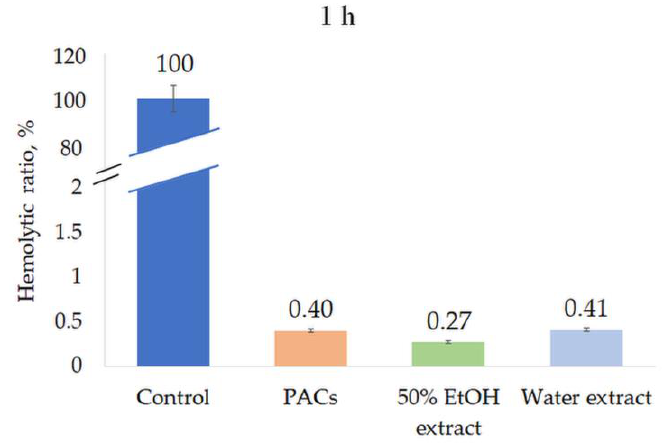
Figure 8. Hemolytic ratio (%) of ‘Maria Bruvele’ twigs’ samples in fresh human blood hemolysis test after 1 h incubation. Control — deionized water, n = 3.